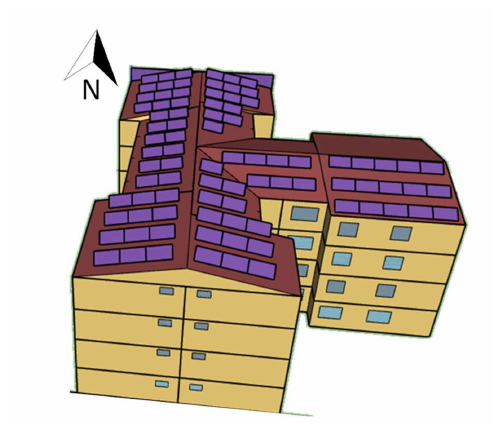
Figure 8. 3-D rooftop view of photovoltaic panels.